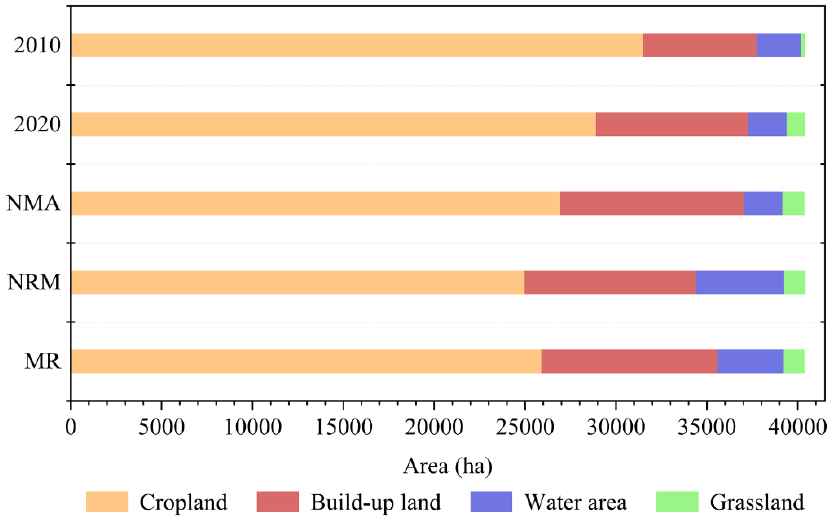
Figure 7. Area statistics for different LULC. (Unused land and woodland are too small to be counted.) From the spatial distribution of different LULC, the new built-up land in 2030